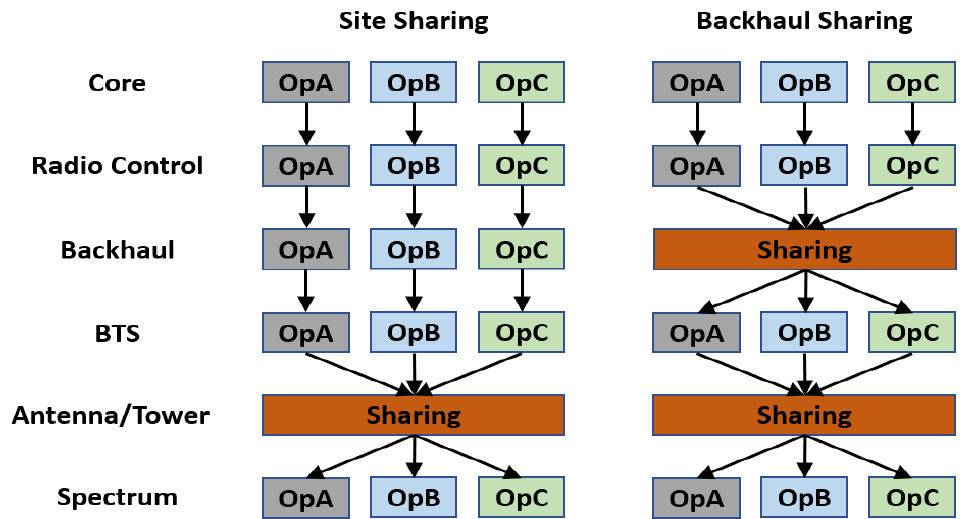
Figure 1. Illustration of passive sharing between three operators.